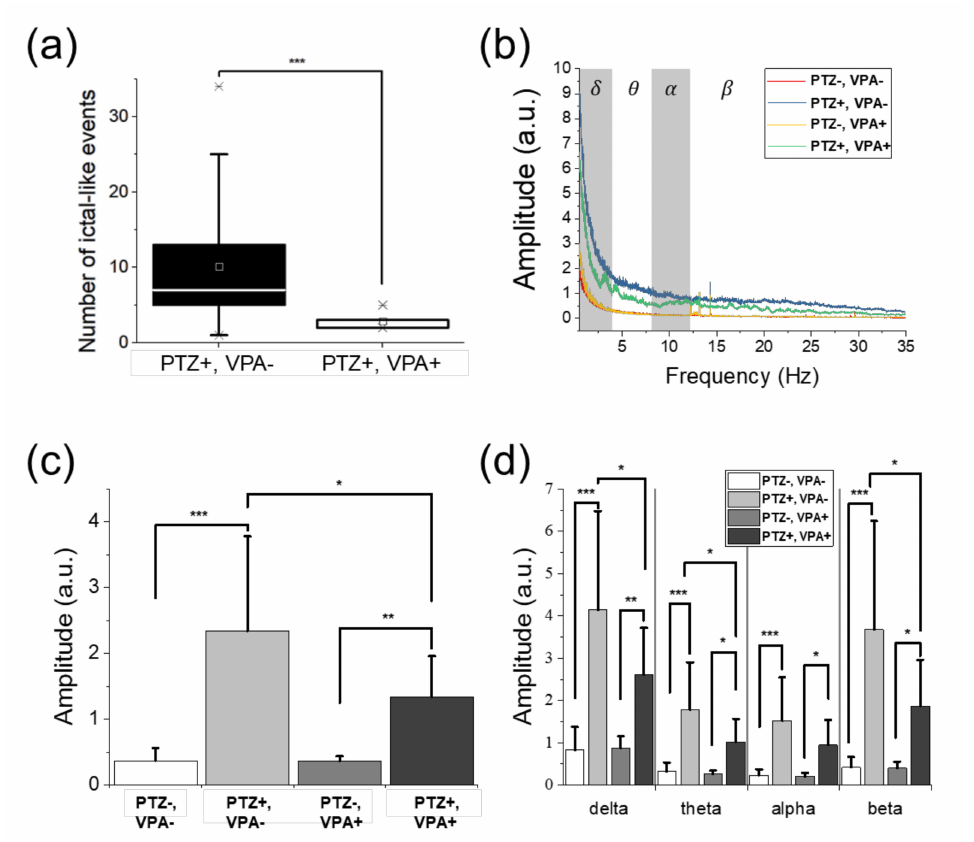
Figure 5. Comparison of the number of ictal-like events and the signal amplitude according to drug applications. ( a ) The number of ictal-like events in both non-treated (n = 26) and VPA-treated (n = 7) groups. In the VPA-treated group, the number of ictal-like events was reduced significantly compared to that of the non-treated group. The boxes show the range from 25% to 75% of the measured data. The lines and squares in the boxes represent the medians and means, respectively, while asterisks represent the values corresponding to 1% and 99% of the data. The error bars indicate the upper and lower boundaries of outlier. ( b ) The averaged amplitude spectra of the non-treated (PTZ-, VPA-), non-treated group with PTZ application (PTZ + , VPA-), VPA-treated (PTZ-, VPA + ), and VPA-treated with PTZ application (PTZ + , VPA + ) groups. The relative change in signal amplitude of each groups ( c ) over the entire frequency range and ( d ) in the divided frequency bands into delta, theta, alpha, and beta bands. In ( b ) and ( c ), the error bars indicate the standard deviations. ( a ) and ( c ) suggest that VPA treatment clearly suppressed the amplitude increase by PTZ. Significant di ff erences were denoted as * for p < 0.05, ** for p < 0.01, and *** for p <